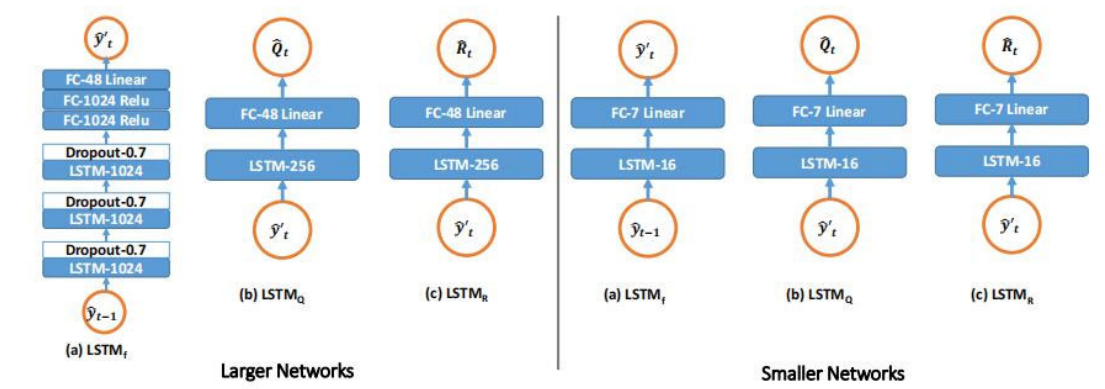
Figure 8. Structure of the LSTM-KF model.